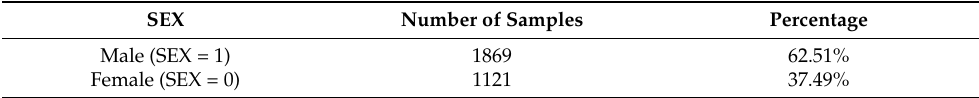
Table 2. Sex distribution of the samples.